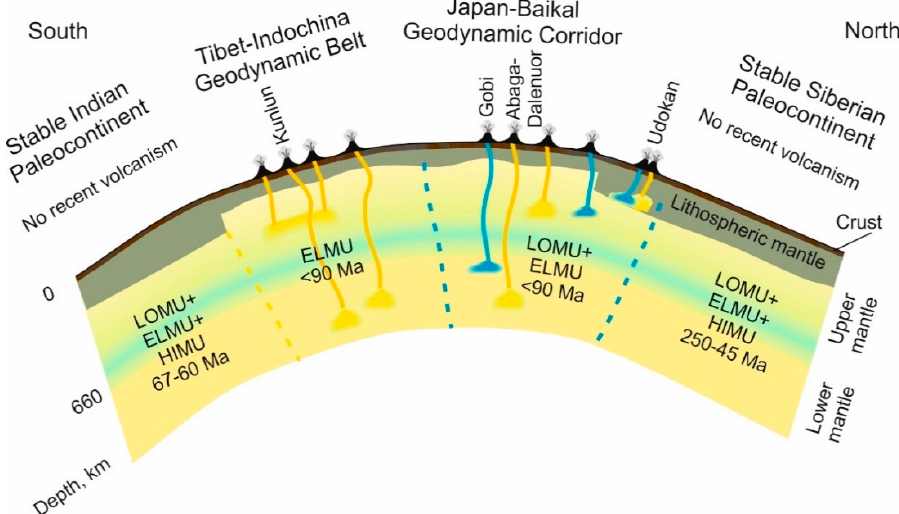
Figure 17. North-south change from ELMU to ELMU – LOMU mantle sources for volcanic rocks of the latest geodynamic stage in unstable Asia and transitions to LOMU – ELMU – HIMU sources of volcanic rocks in stable regions of the Siberian and Indian paleocontinents.